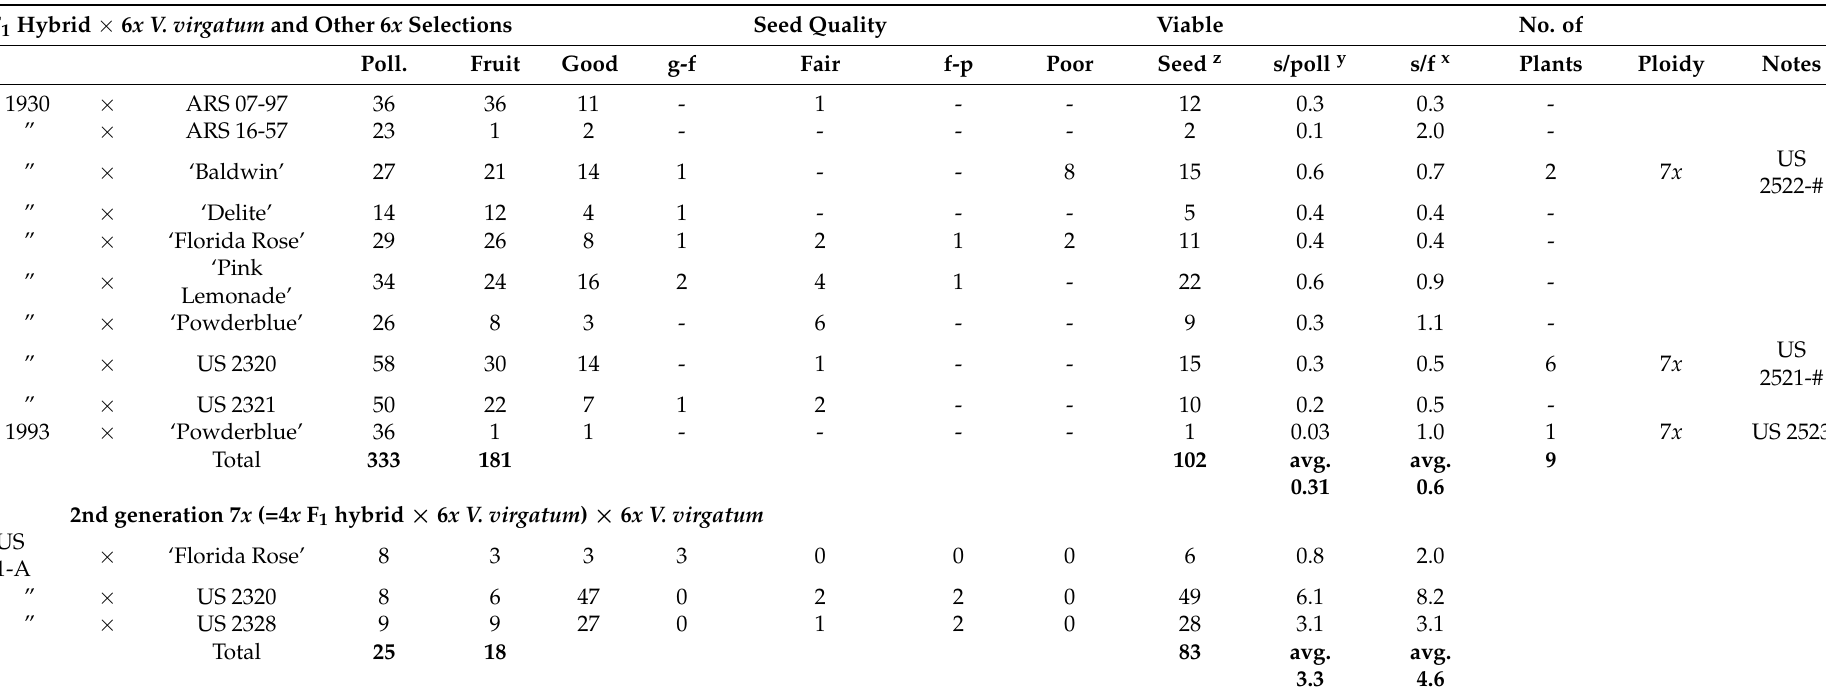
Table 2. Crosses of 4 x V. meridionale — V. vitis-idaea hybrids (US 1930, US 1993) as females with 6 x males, and an advanced generation 7 x hybrid (US 2521-A) as female with 6 x